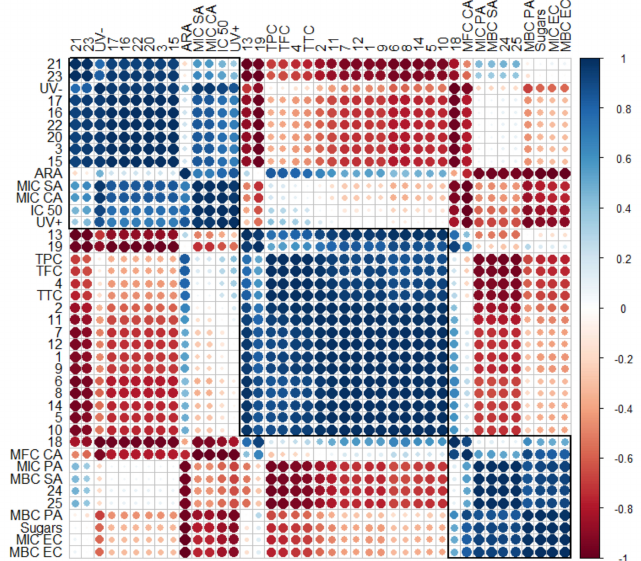
Figure 6. Variation in chemical composition and biological activity of Matricaria recutita white ray floret supercritical fluid extracts. The legend denotes scaled values of the volatile chemical constituents (No 1-25, according to Table 4), total phenolics (TPC), flavonoids (TFC), tannins (TTC), sugars (according to Table 2), antiradical (ARA) and antimicrobial activity (according to Table 6), cytotoxicity, and phototoxicity (according to Figure 5).